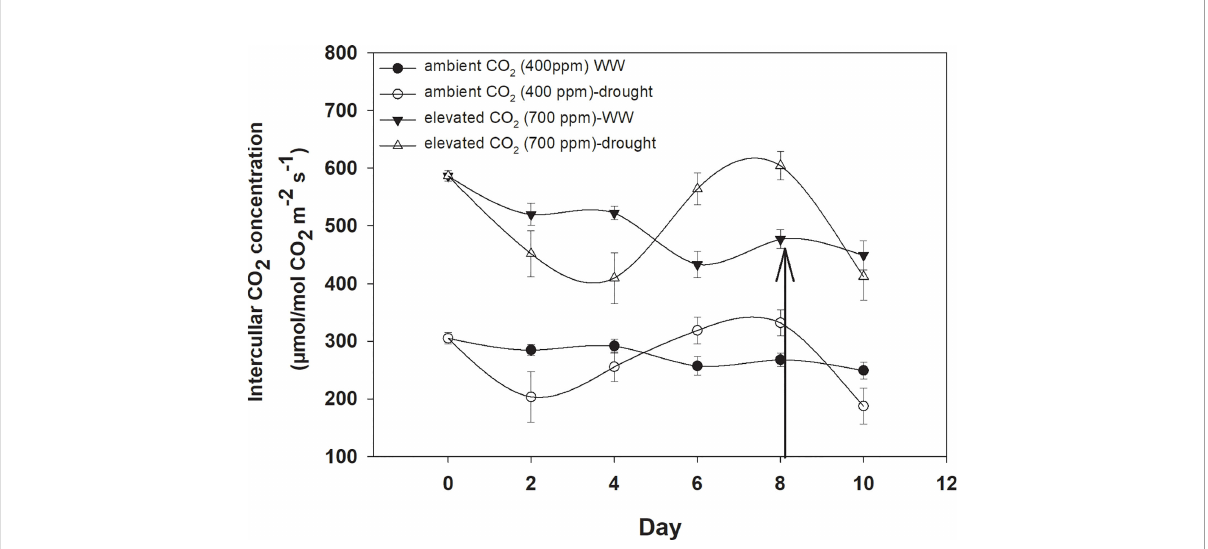
FIGURE 2 Effect of CO 2 concentrations and moisture conditions on intercellular CO 2 concentration of Datura stramonium . The vertical line on the data point represents the standard error of the mean and the vertical arrow line after Day 8 represents the addition of water in the drought treatments. WW,